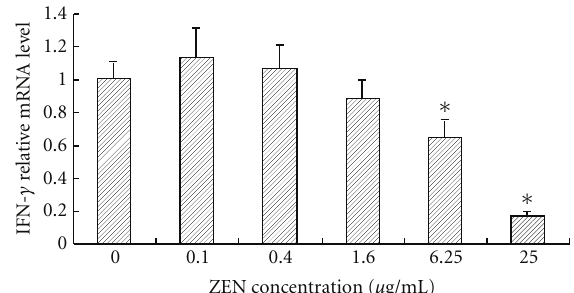
Figure 3: The e ff ect of ZEN on the IFN- γ relative mRNA level in ConA-stimulated lymphocytes at toxin concentrations of 0, 0.1, 0.4, 1.6, 6.25, and 25 μ g/mL at 48 h. The reporter activity in response to ConA alone is expressed as 100%. Values are the means ± SD from three independent experiments. Statistical analysis was performed using one-way ANOVA followed by Dunnett’s post hoc test ( ∗ P < 0 . 05 versus ConA treated